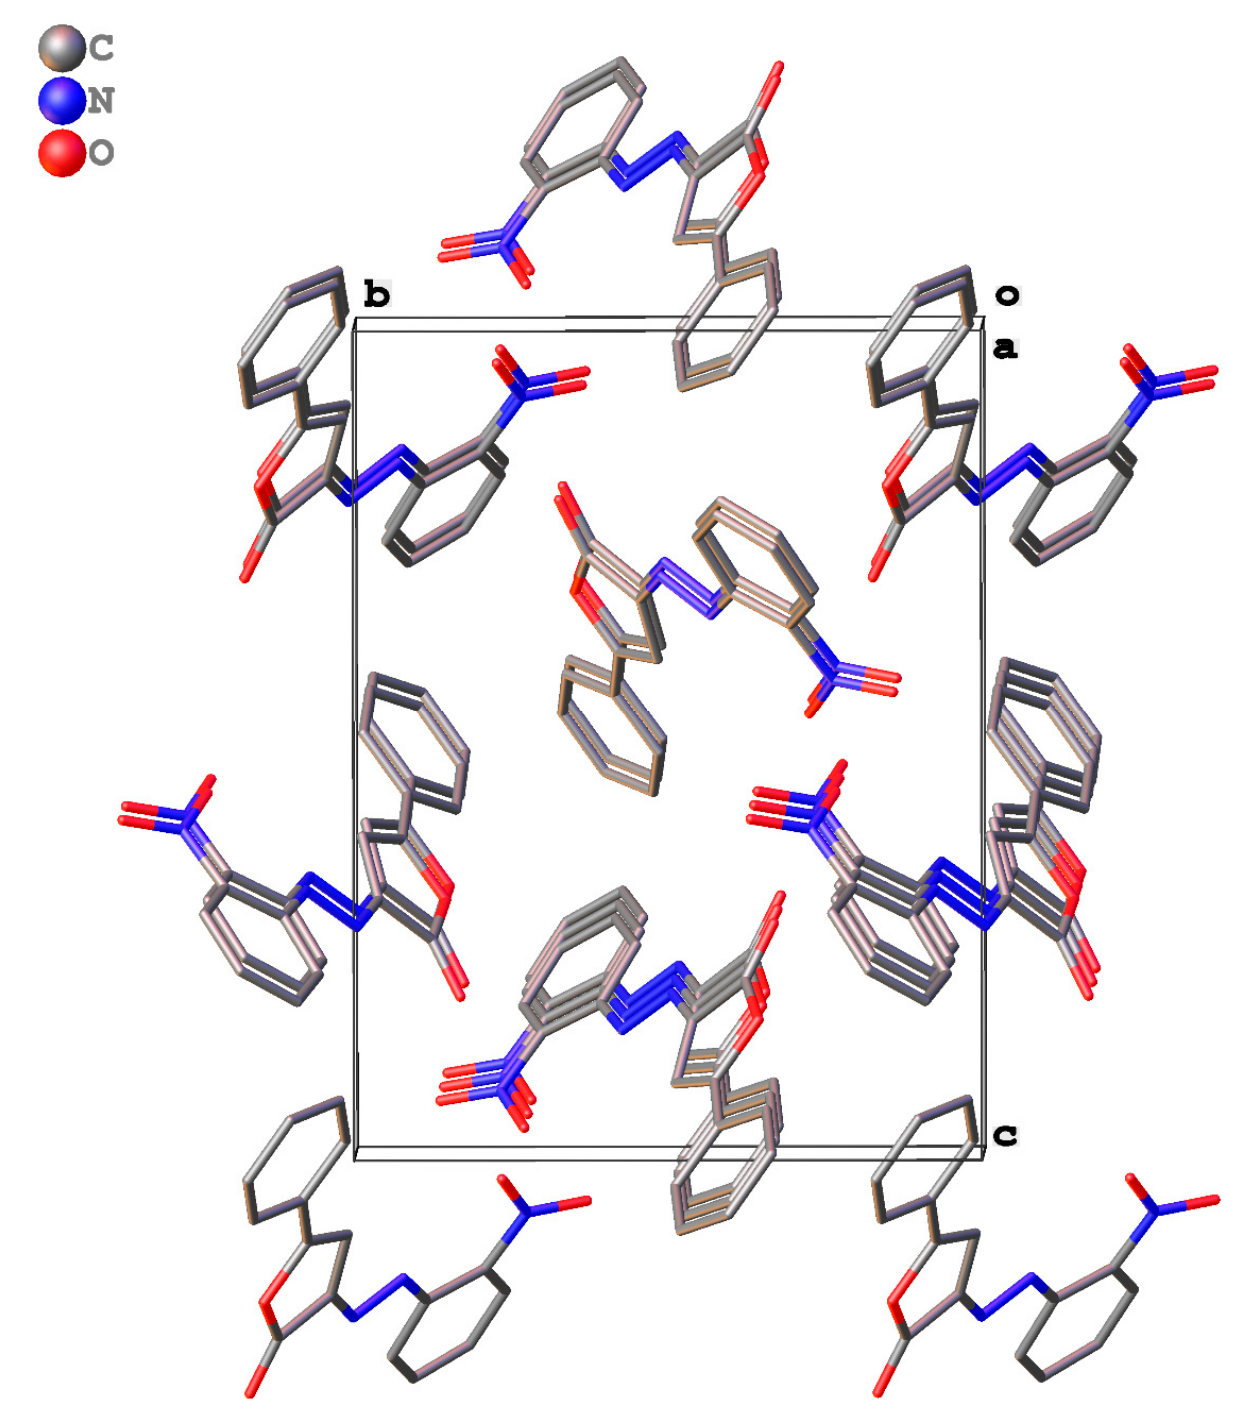
Figure 5. Extended packing diagram of molecules of ( 2 ), view along the a axis. Hydrogen atoms omitted for clarity. Centroid–centroid distance of the benzene and furan-2(3 H )-one rings of 7.47720(10) Å and ring offset of 6.675(2) Å indicate no non-covalent interactions between mole- cules.